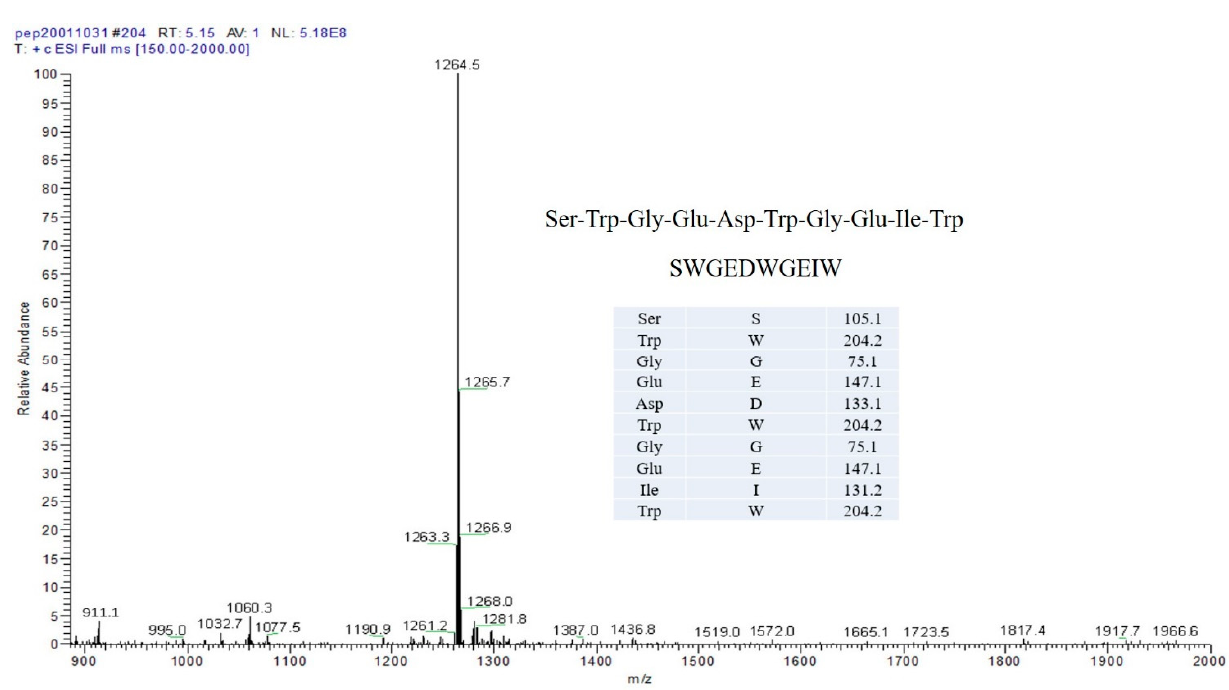
Figure 5. Mass spectra of